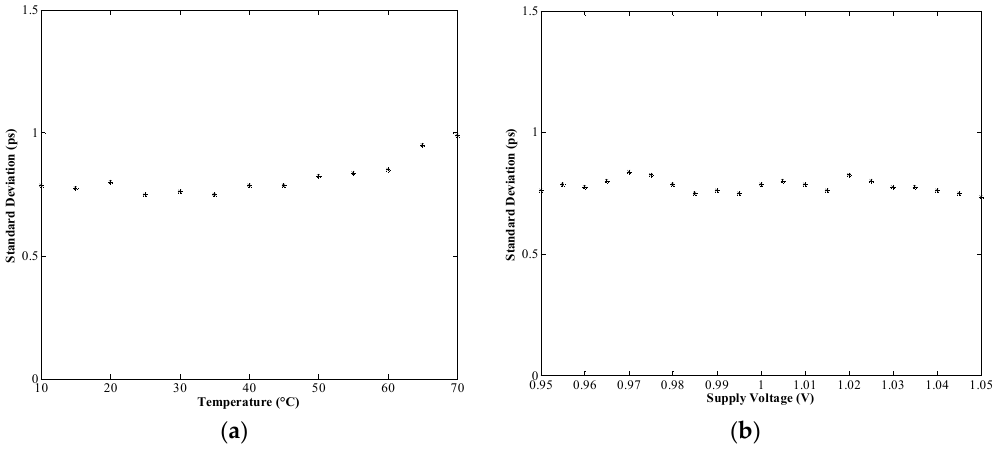
Figure 12. ( a ) Temperature stability of the proposed DTC. ( b ) Voltage stability of the proposed DTC.